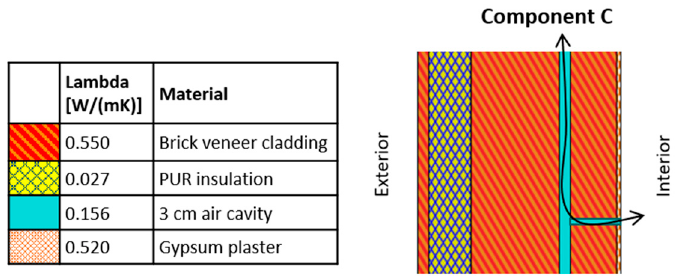
Figure 3. Vertical section of the post-retrofit front facade at component C.